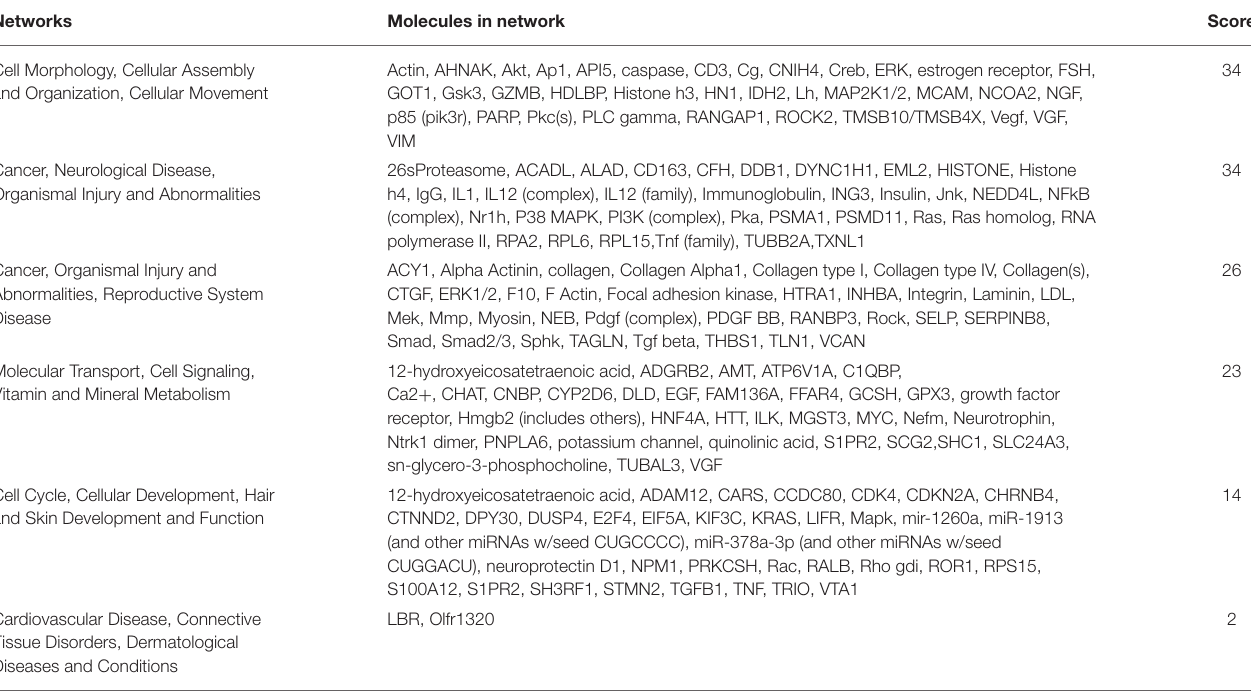
TABLE 3 | IPA bioinformatics analysis of the proteins differentially expressed in ns-Zr15 vs NGF. Networks Molecules in network Cell Morphology, Cellular Assembly and Organization, Cellular Movement